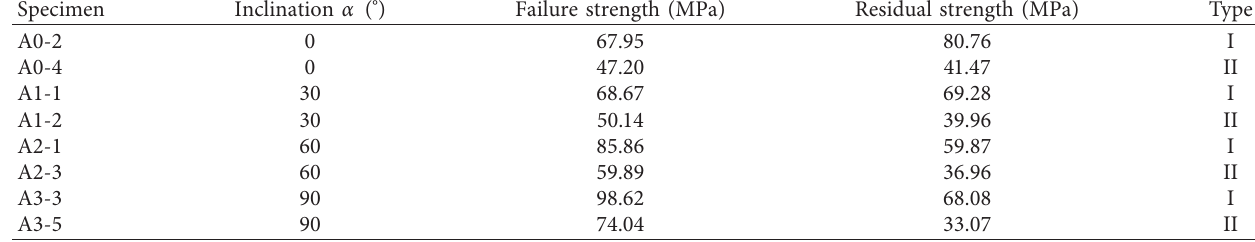
Table 3: Strength of the rock-like specimens with varying fissure inclinations under type I and II tests. Specimen